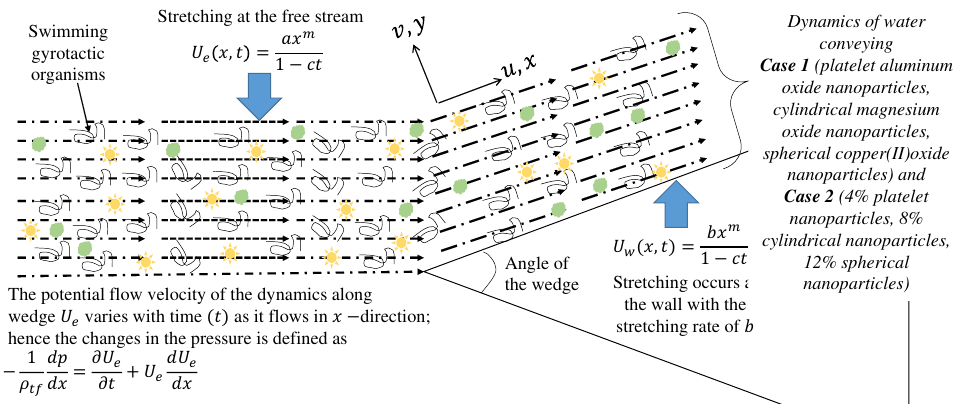
Figure 1. Physical configuration of the transport